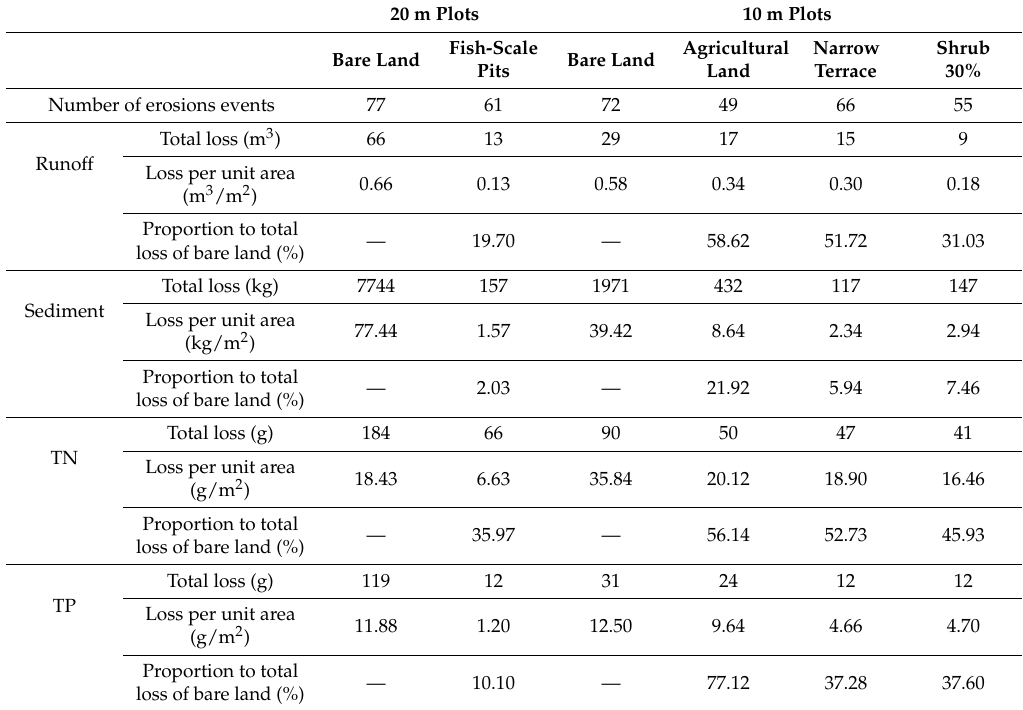
Table 2. Runoff, sediment and nutrient losses in different runoff sites during 2010–2015 (total loss is the monitored value; loss per unit area is obtained by dividing the monitored value by the plot area, and proportion to total loss from bare land is the proportion of the corresponding plot of the bare land with the corresponding size.). 20 m Plots 10 m Plots Agricultural Narrow Shrub Fish-Scale Bare Land Bare Land Land Terrace 30% Pits Number of erosions